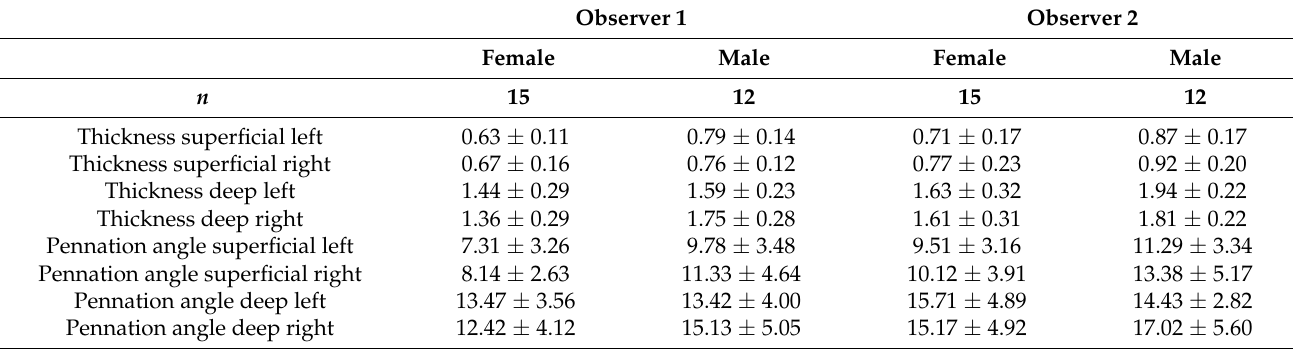
Table 2. Ultrasound morphology by